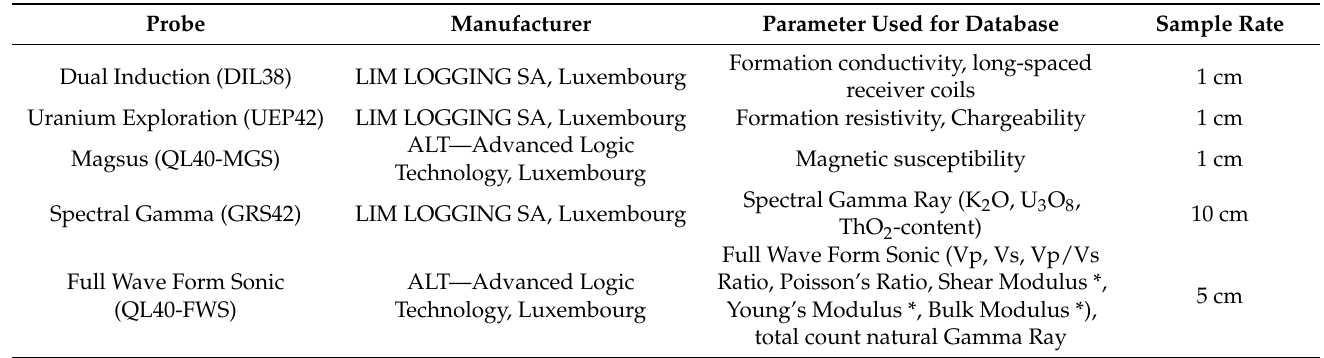
Table 2. Overview of the borehole probes applied, and the parameters used for the petrophysical database for each